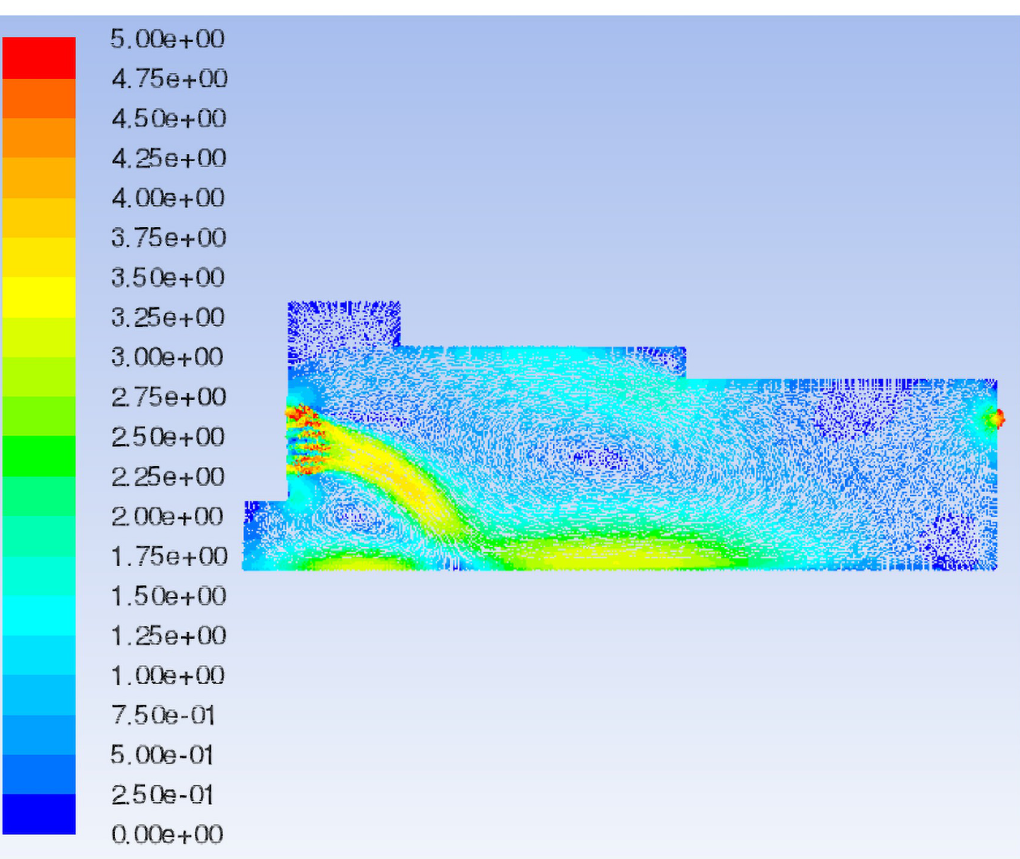
Fig 11. Flow field velocity vector of the reduced air volume